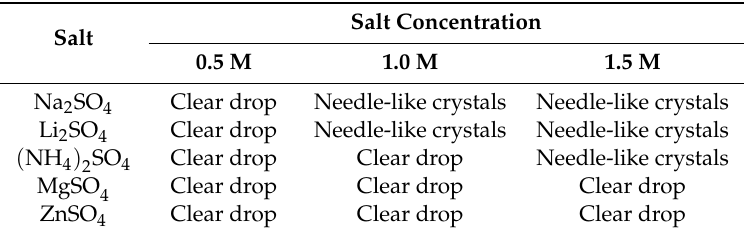
Results of anti-CD20 crystallization after seven days using several sulfate salts at di ff erent